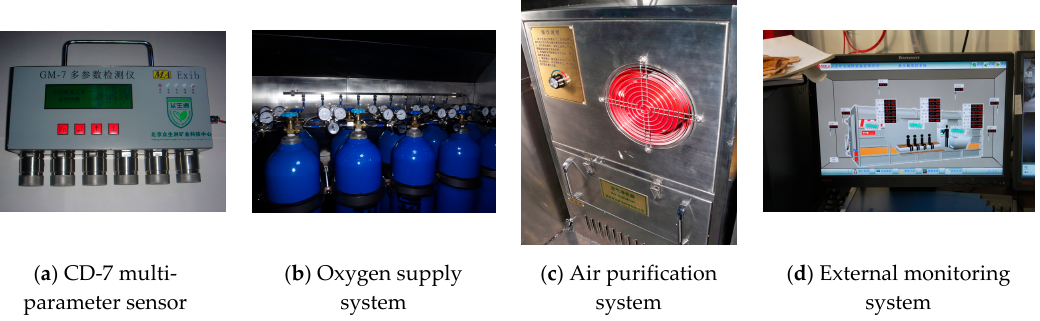
Figure 3. Composition of the cabin system.